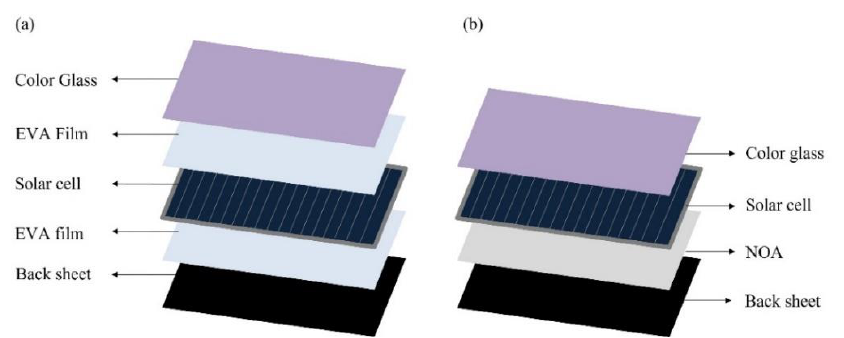
Figure 2. Solar cell lamination process for the BIPV system. ( a ) Existing process using EVA film; ( b ) proposed lamination process without EVA film.